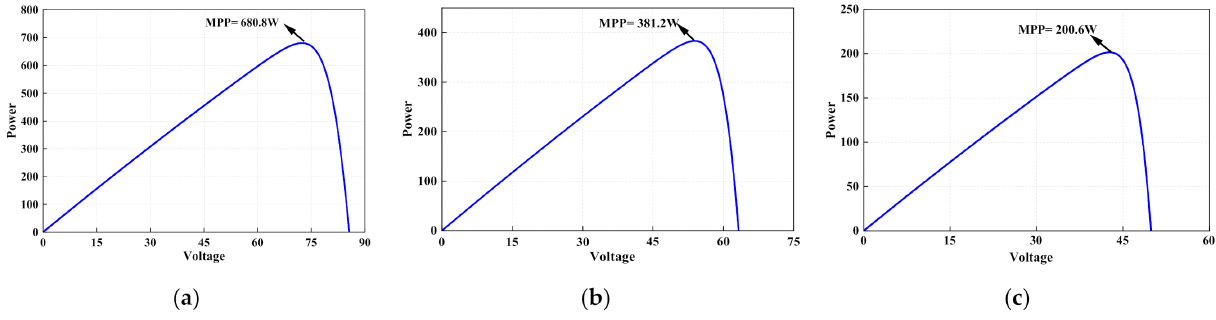
Figure 9. PV Curves of uniform irradiance cases: ( a ) STC (1000 W/m 2 ), ( b ) UI-1 (700 W/m 2 ), ( c ) UI-2 (500 W/m 2 ).